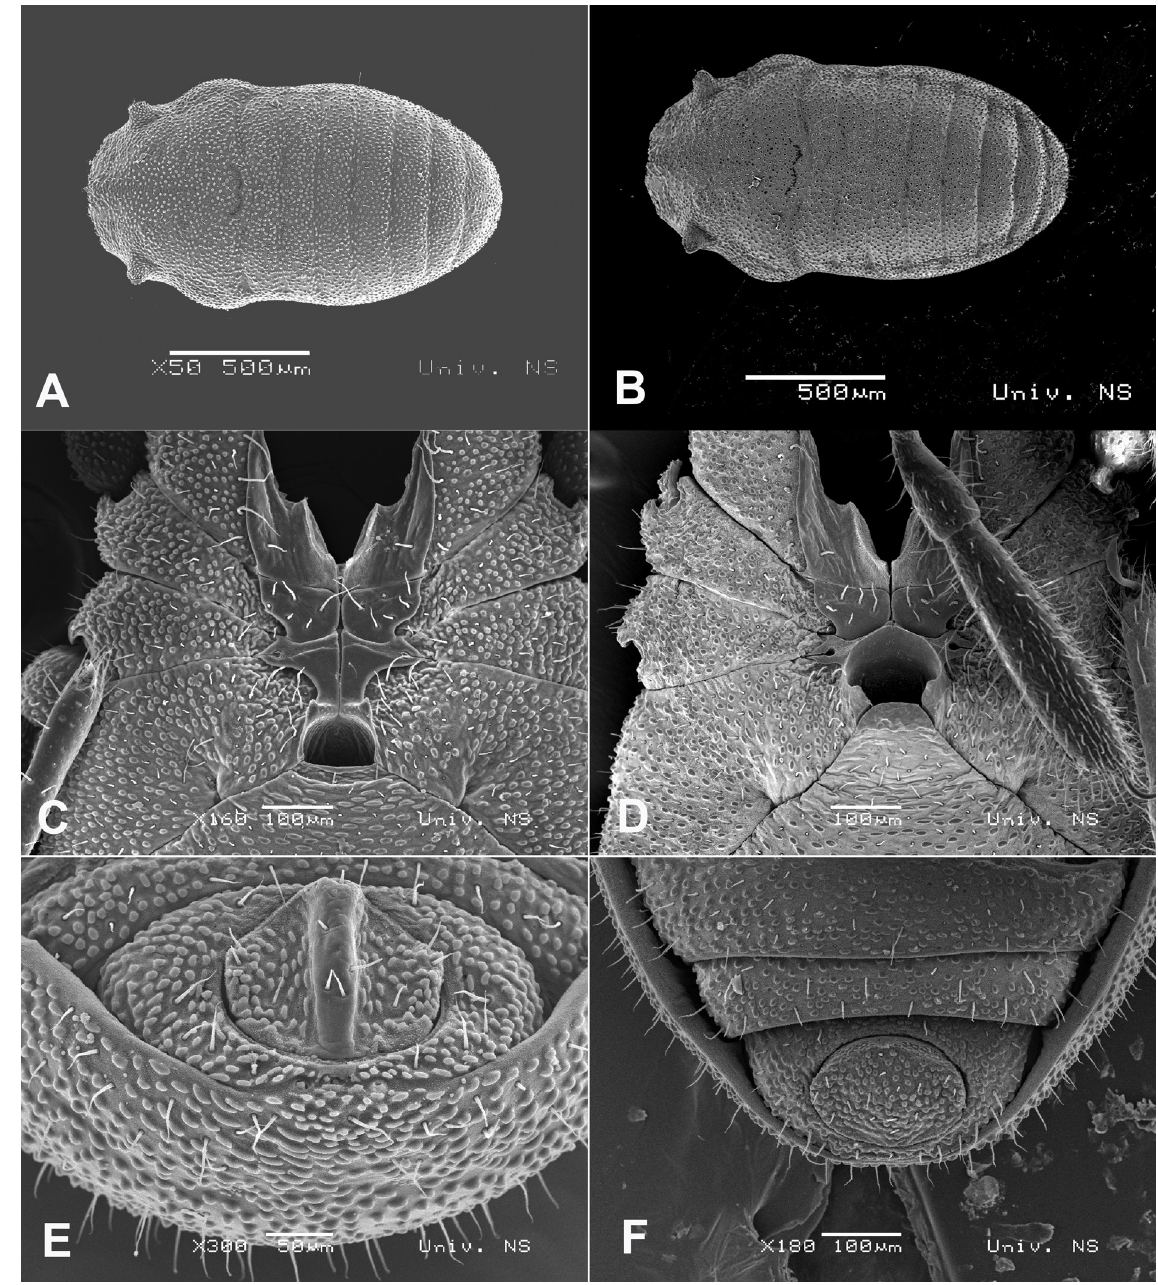
Fig. 4. Siro franzi Karaman & Raspotnig sp. nov. A, C, E . Paratype, ♂ (IKC1538). B, D, F . Paratype, ♀ (NHMW 28759). A–B . Dorsum. C–D . Ventral prosomal complex. E . Anal region, subventral view. F . Anal region, ventral